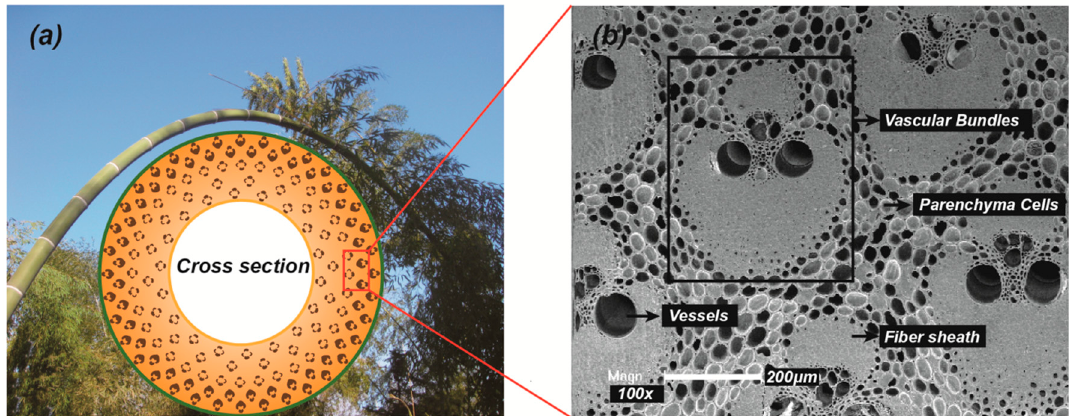
Figure 1. ( a ) Excellent bending flexibility of bamboo with hollow structure and FG structure in cross section under heavy snow; ( b ) Field emission scanning electron microscope (FESEM) micrograph of microstructure of bamboo culm with different constituents.